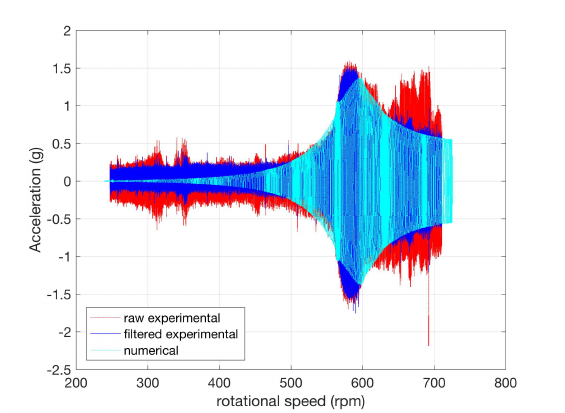
Figure 12. Comparison of raw experimental data (red) against filtered experimental data (blue) and simulated data (light blue): revolutions per minute/acceleration.